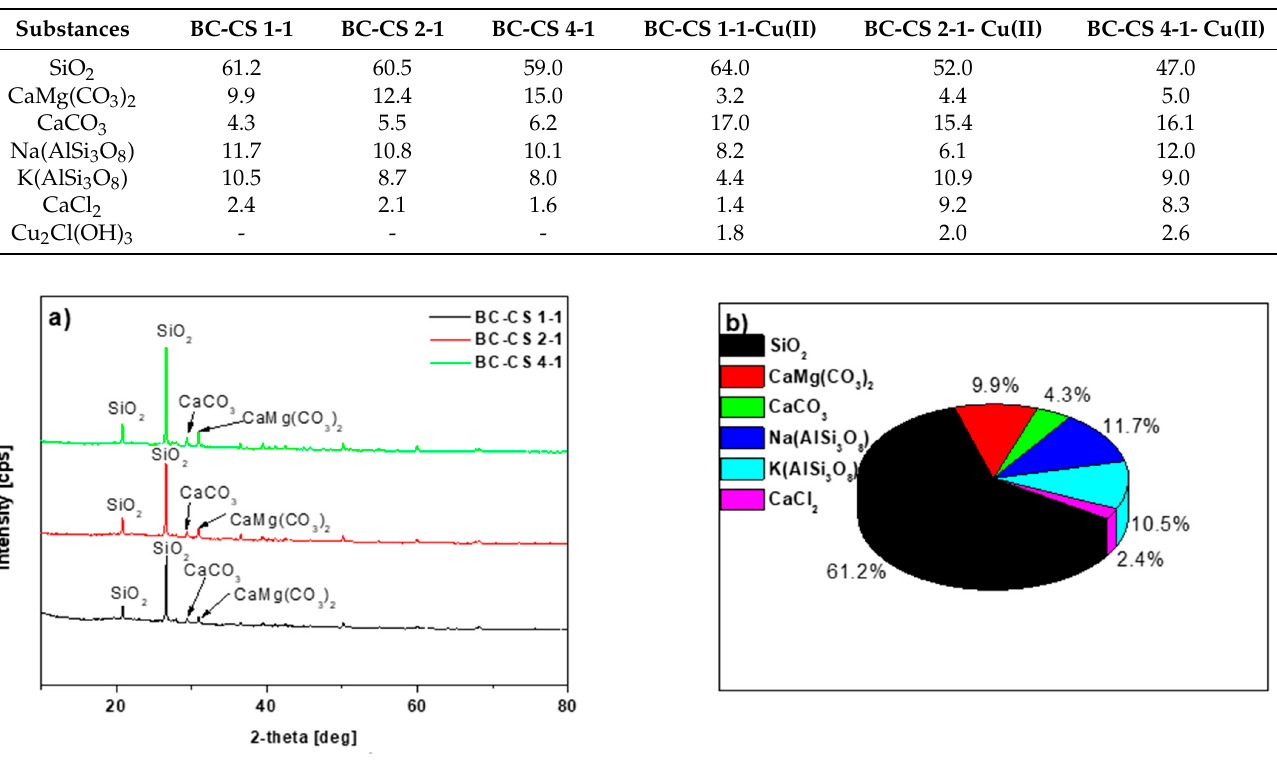
Figure 5. ( a ) XRD analysis of the chitosan-modified biochars, and ( b ) percentage values of the substances in BC-CS 1-1.